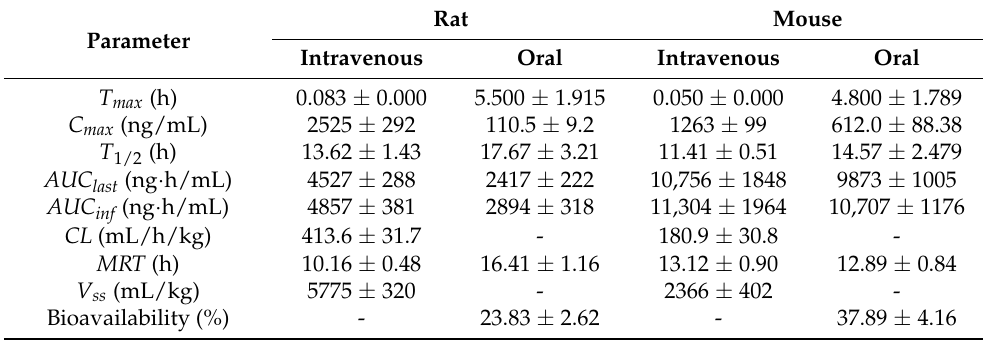
Table 4. Pharmacokinetic parameters of ARV-110 after IV and PO administration to rats and mice ( n = 4). Rat Mouse Parameter Intravenous